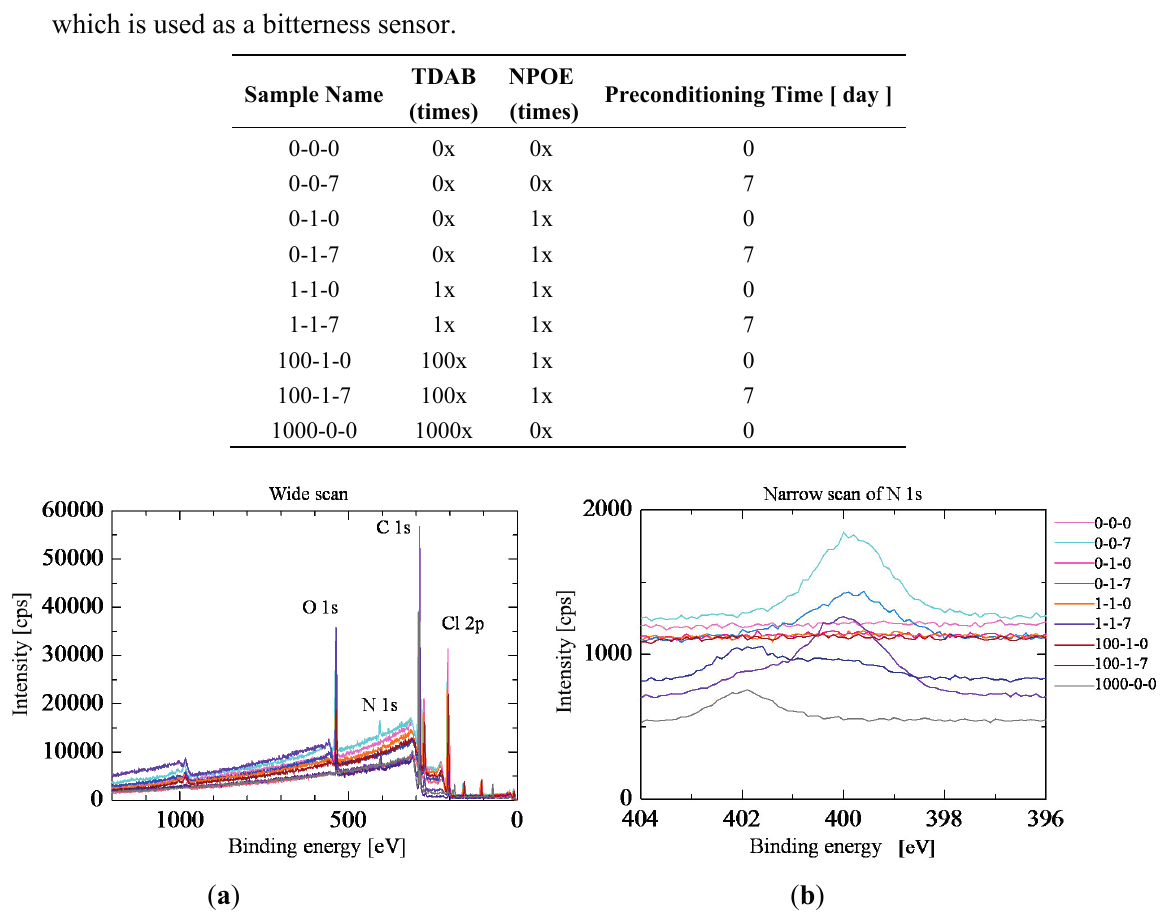
Figure 6. The result of XPS measurement. The upper graph is the result of wide scan. The lower graph is the result of narrow scan for signal of nitrogen 1s. The red lines are the results of samples without preconditioning. The blue lines are the result of samples with preconditioning. ( a ) Wide scan; ( b ) Narrow scan of Nitrogen